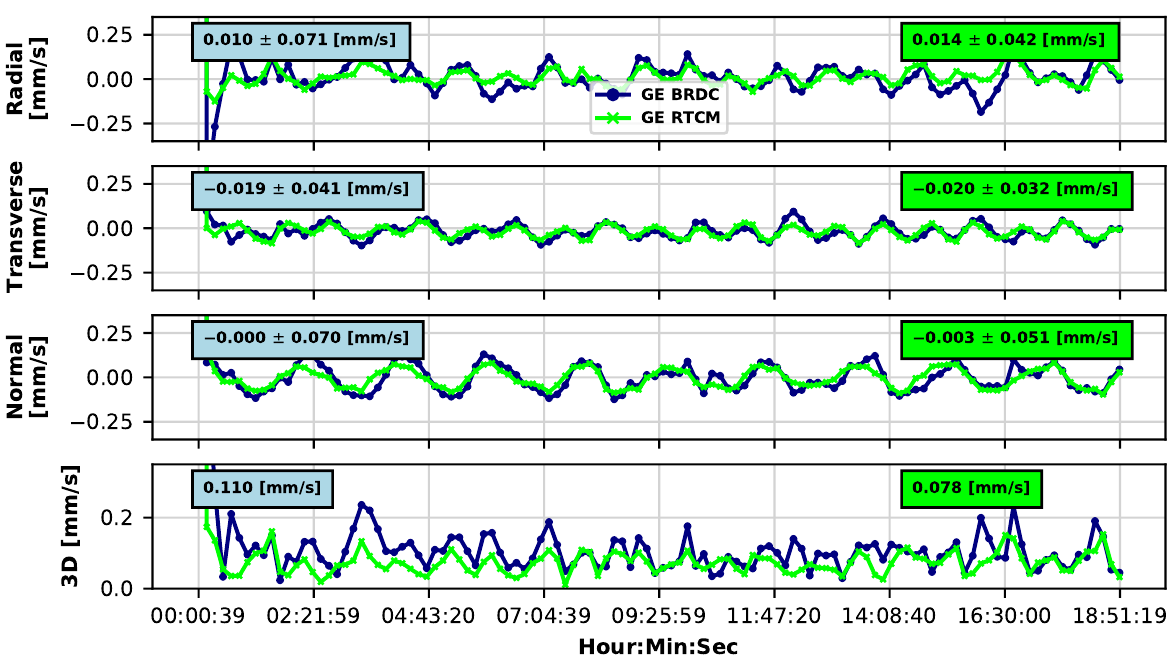
Figure 2. S6A orbital velocity difference with respect to CNES-POD reference solution on 4 September 2021. Two solutions are compared: the first is obtained by using only broadcast navigation data (blue-colored lines), and the second is found by correcting the broadcast navigation data using RTCM corrections from CNES (green-colored lines). For the individual axes (RTN frame), the mean values standard deviation of the differences are provided (light-blue-filled boxes for BRDC and ± light-green-filled boxes for RTCM). The RMS value is shown for the 3D